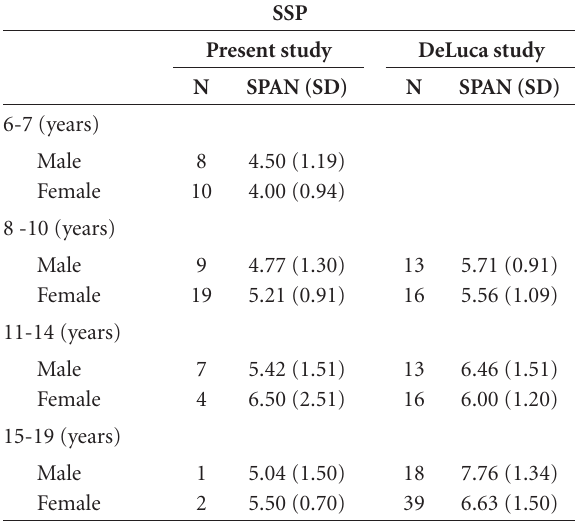
Table 5. Means and standard deviations for SSP by age group and gender in present study and DeLuca 17 study.